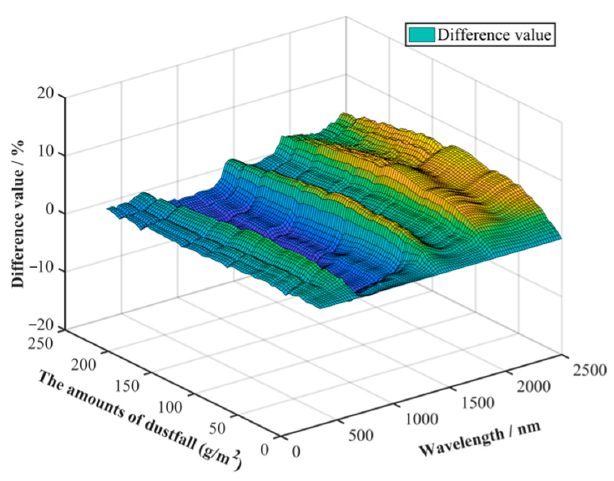
Figure 14. The difference between the corrected results and the measured values.